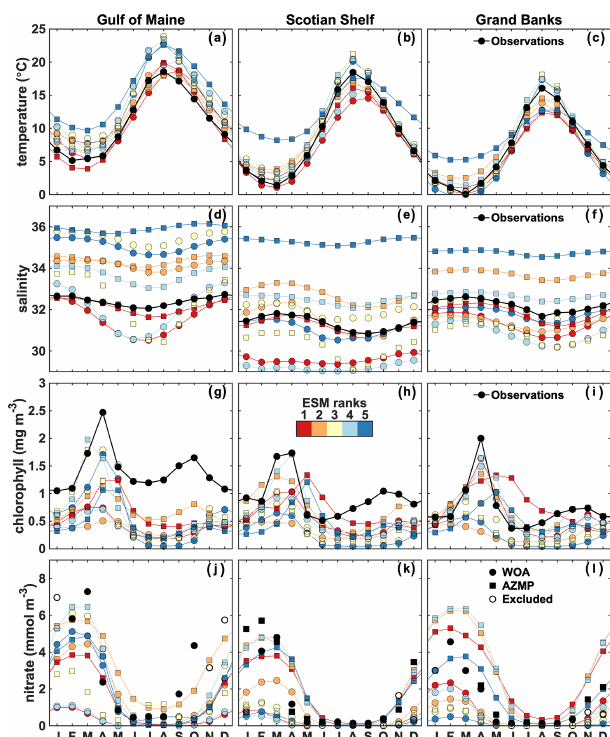
Figure 5. Observed (black dots) and best ESMs’ area-averaged sur- face temperature (a–c) , salinity (d–f) , chlorophyll (g–i) and nitrate (j–l) in the three NWA shelf regions. The colored circles and squares indicate the CMIP5 and CMIP6 models, respectively. November– January WOA nitrate data are excluded (open circles). Model com- parison with observations in the Gulf of Maine is therefore only available from February to October. For the Scotian Shelf and Grand Banks, additional AZMP data are available. In the case of multiple observations, the data are monthly